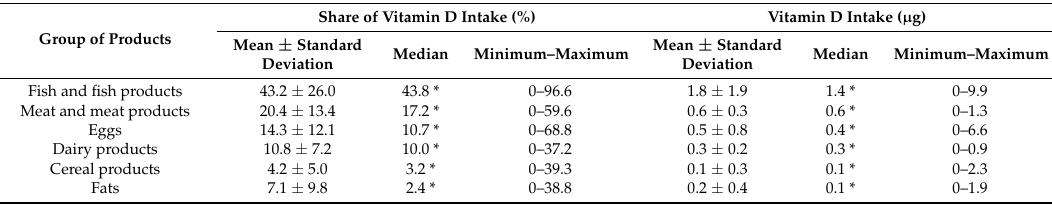
Table 3. The contribution of product groups into the daily vitamin D intake calculated based on the Cro-VIDEO-FFQ1 questionnaire (the food frequency questionnaire to assess vitamin D intake in the first stage).